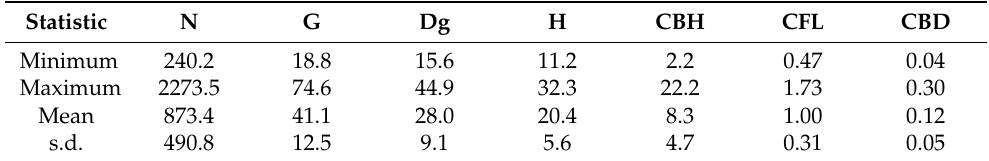
Table 3. Descriptive statistics of stand variables obtained in the 2016/2017 field inventory plots ( n = 30). N, stand density (trees/ha); G, basal area (m 2 /ha); Dg, Quadratic mean diameter (cm); H, Stand height (m); CBH, canopy base height (m); CFL, canopy fuel load (kg/m 2 ); CBD, canopy bulk density (kg/m 3 ); s.d., standard deviation.